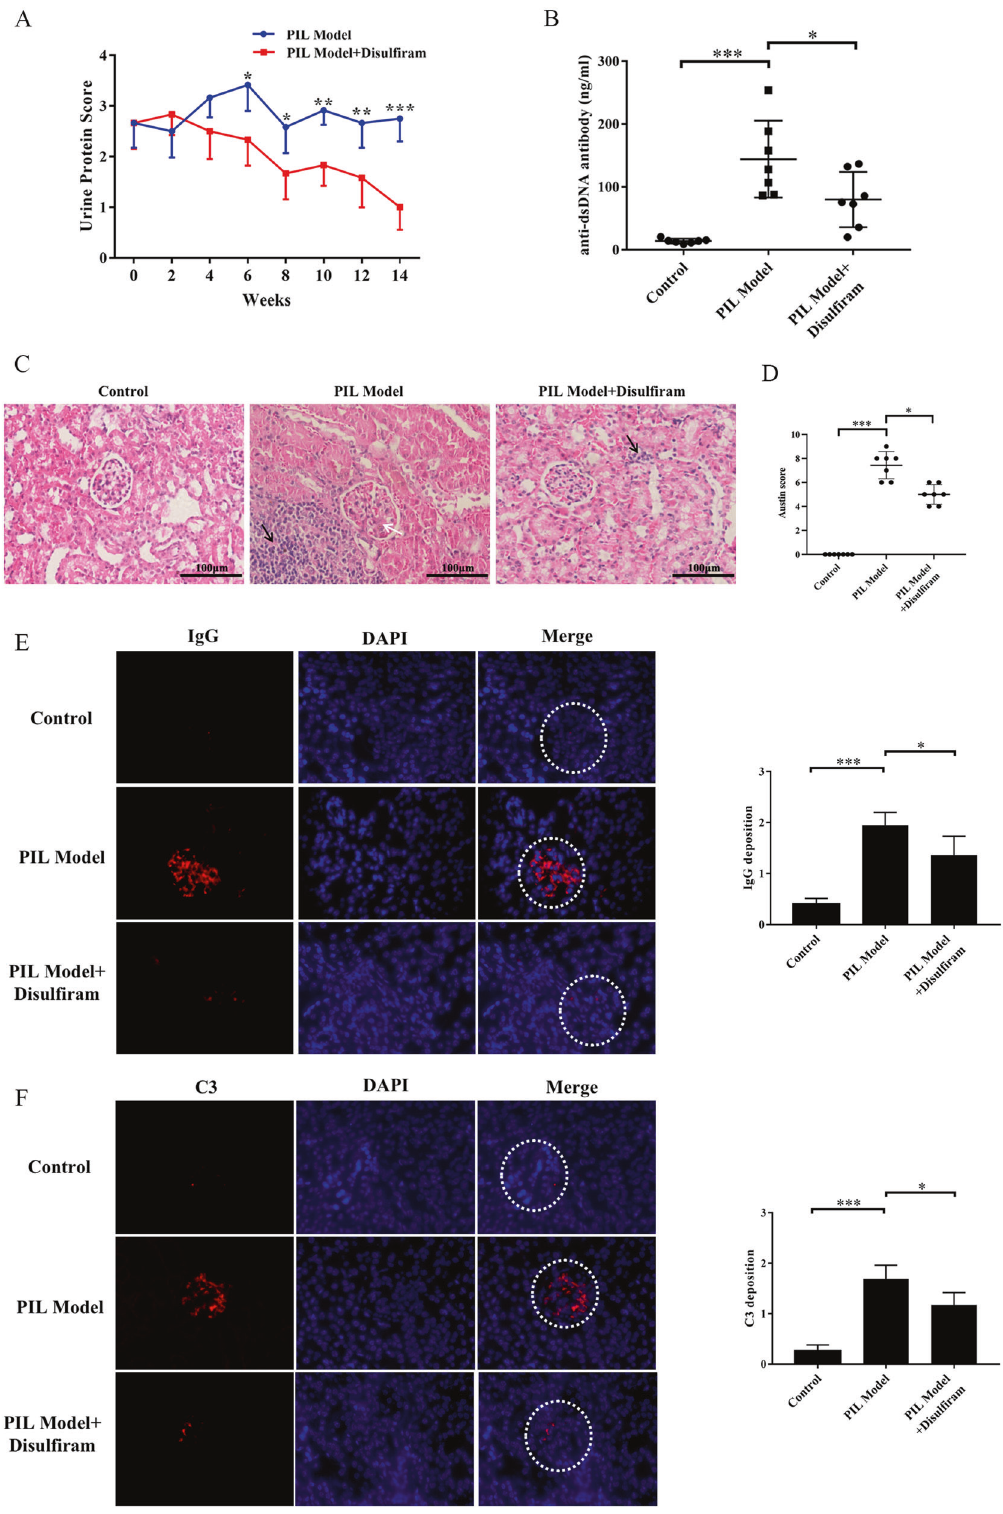
Fig. 3 DSF ameliorated lupus-associated manifestations in PIL mice. PIL mice were treated with a dose of 50 mg/kg DSF or equivalent sterile saline for 14 weeks. A Proteinuria of mice in each group was assessed using Albustix test every 2 weeks. B The level of serum